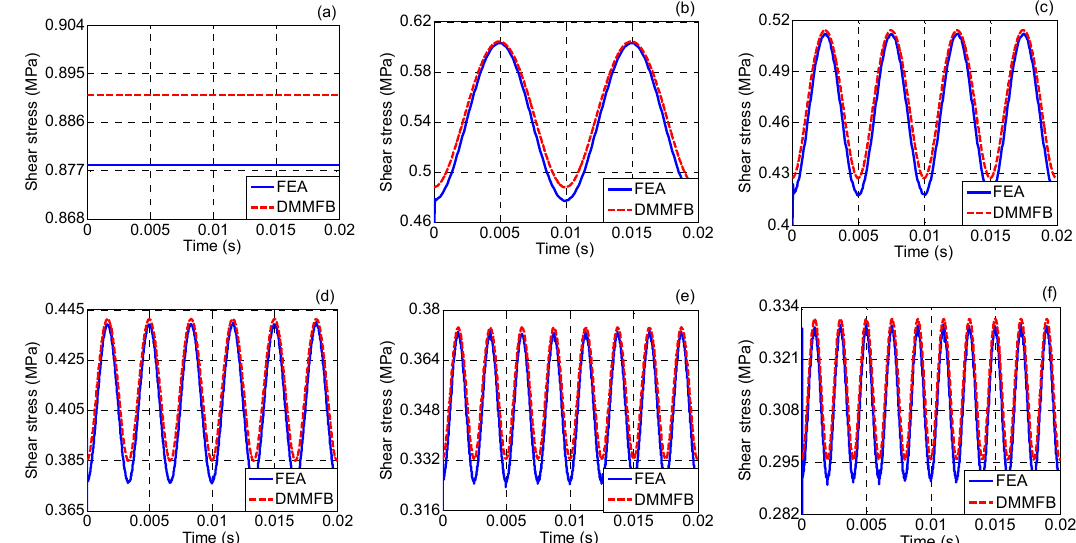
Figure 10. The shear stress at the internal wall of the extrusion liquefier without and with 0.35 g vibration applied at di ff erent frequencies. ( a ) No vibration applied, ( b ) 100 Hz, ( c ) 200 Hz, ( d ) 300 Hz, ( e ) 400 Hz, ( f ) 500 Hz. E ff ective value of the shear stress without and with 0.35 g vibration applied at di ff erent